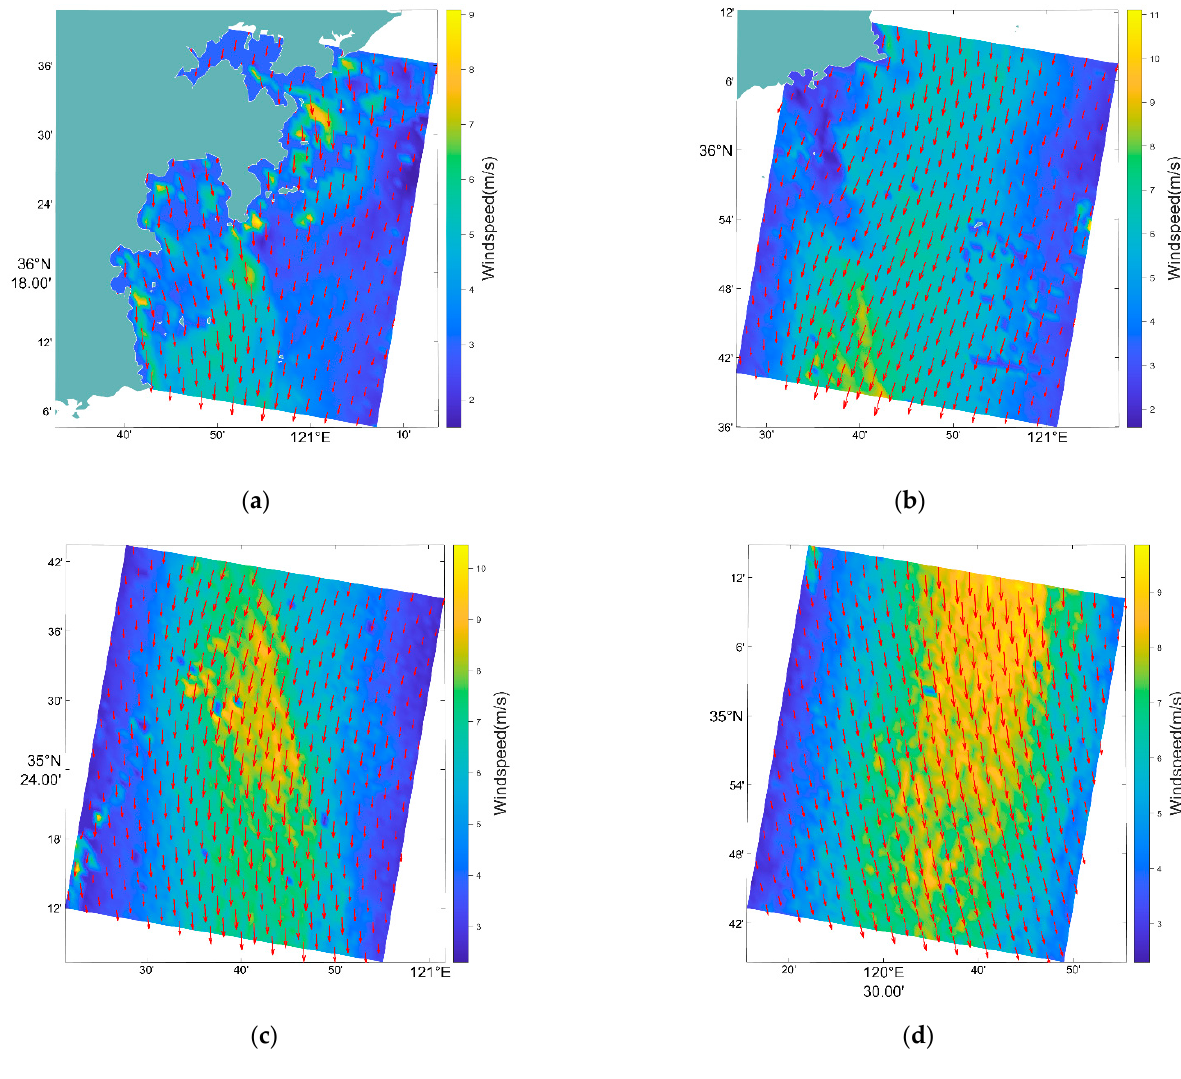
( e ) Figure 3. The input wind field of the five scenes. (a)~(e) are the wind fields in red square area of figure 1. 4.4.2. ECMWF Reanalysis Wind Field ERA5 is the fifth-generation of ECMWF reanalysis of global climate and weather over the past four to seven decades. Currently, the data are available from 1950, with climate data store entries for 1950–1978 (preliminary back extension) and from 1959 onwards (fi- nal release plus timely updates, this page) [20]. In the experiments, the European Centre for Medium Weather Forecasts (ECMWF) reanalysis wind field (ERA3) was applied, be- cause there was no on-site wind measurement instrument. Its time resolution was 6 h, and the spatial resolution was 0.25° (about 25 km) [17]. The SAR images were re-analyzed at similar times, at 21:00 and 22:00, by selecting the latitude and longitude range of images (b) and (c), to interpolate to the accurate SAR image time. The results are shown in Figure 4.